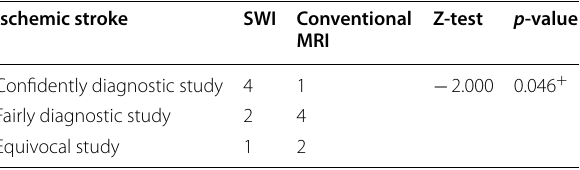
Table 4 Comparison between SWI and conventional MRI for arterial ischemia diagnosis